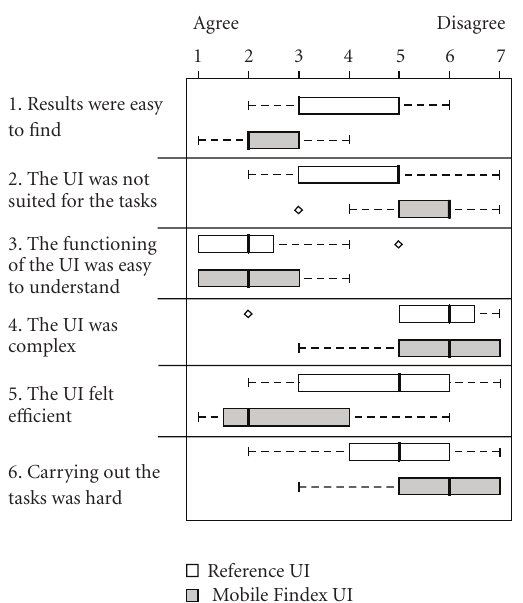
Figure 4: Subjective ratings of Reference UI and Mobile Findex UI.